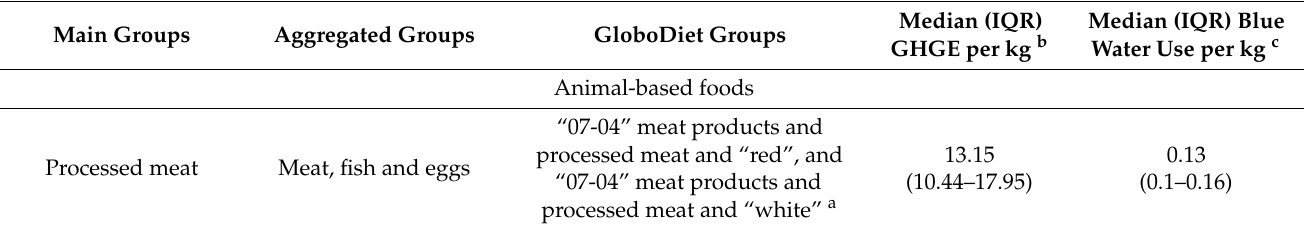
Table A2. Categorization of 21 food groups adapted from GloboDiet, and their greenhouse gas emission (GHGE) (kg CO 2 equivalents) and blue water use (m 3 ) per kg based on median consumption of participants of the Dutch National Food Consumption